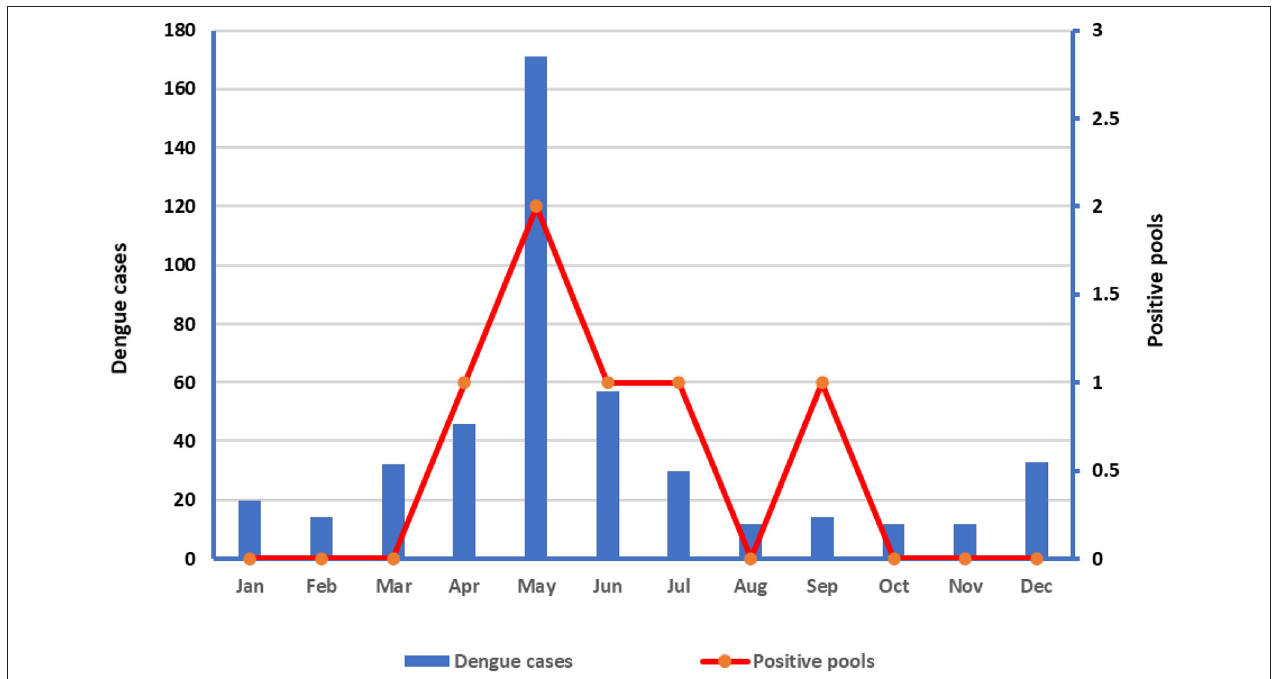
FIGURE 3 | Dengue cases and dengue positive mosquito pools detected by